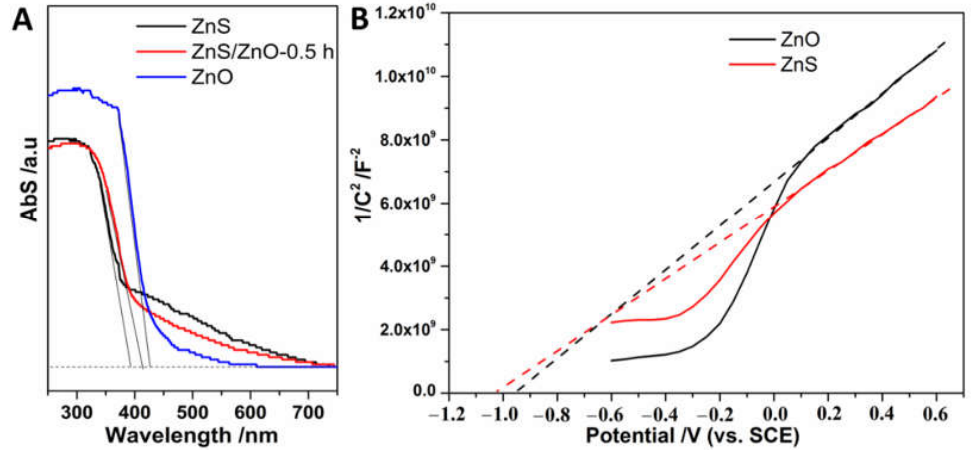
Figure 7. ( A ) The Uv-vis Abs spectra of ZnS, ZnS/ZnO-0.5 h and ZnO; ( B ) Mott–Schottky plots of ZnO and ZnS.